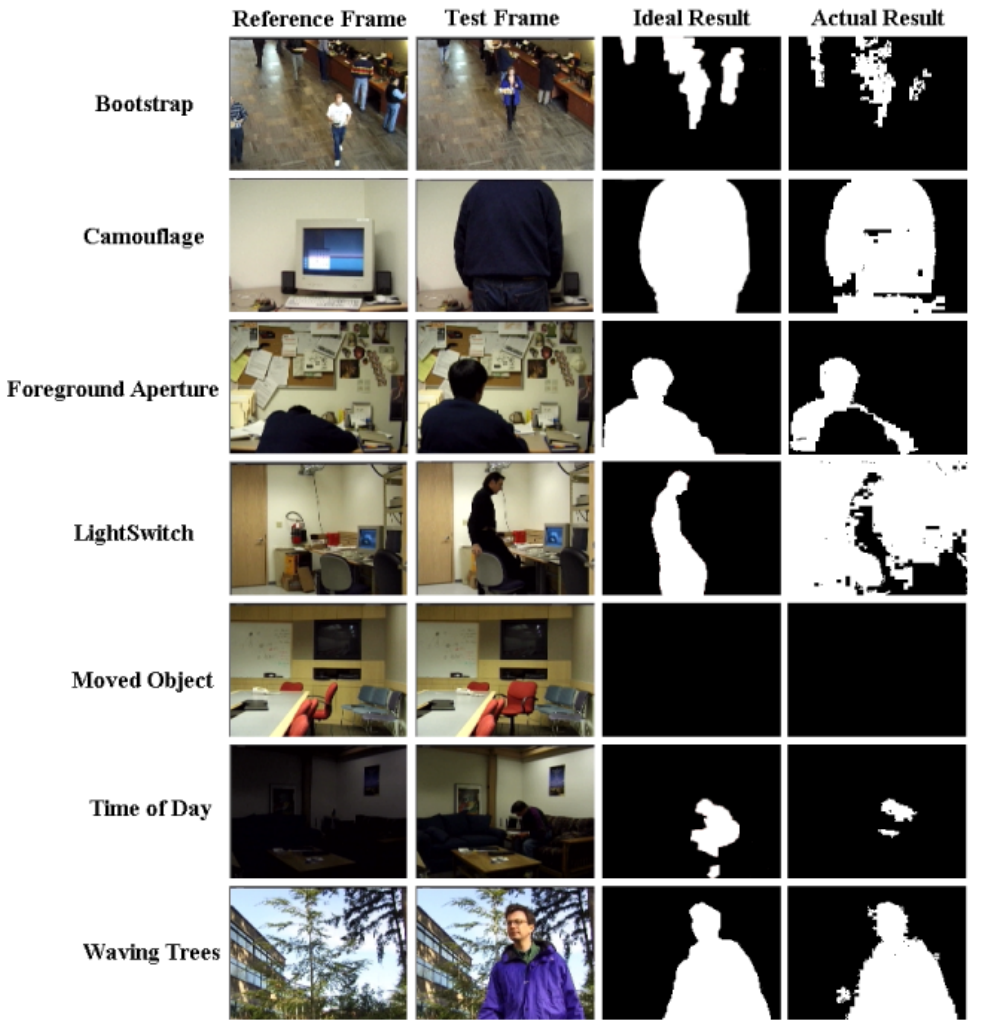
Figure 9. Detection results of the proposed method for the Wallflower